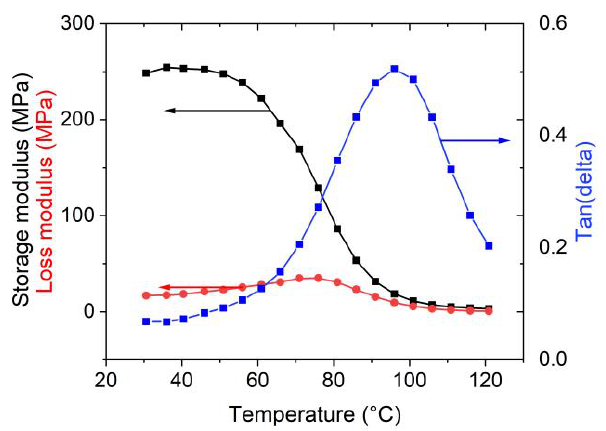
Figure 3. The diagram of storage and loss moduli, and internal friction as a function of temperature from 30 °C to 120 °C.